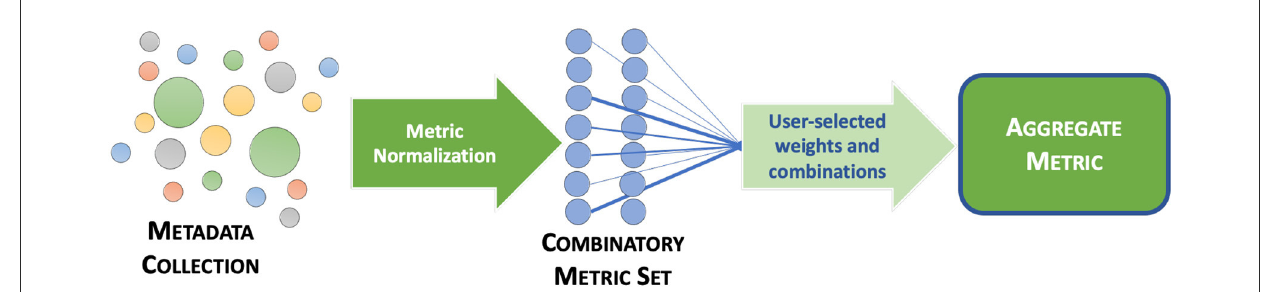
FIGURE2 Conceptual framework of the risk-triage approach. The supporting web platform consists of a metadata collection obtained from various repositories and sources whose data differ in attributes, formats, content, units, granularities, etc. (i.e., Appendix A). From this ecosystem of data, a subset of the data is chosen that span across the multi-sector dynamics (MSD) purview (e.g., Reed et al., 2022). These data are further refined and normalized into a set of metrics that can be used for combinatory analyses. The platform is designed to be flexible and interactive—such that the user can select their own combination and weights (conceptually depicted by the line thicknesses) of these metrics. The result is an aggregate metric where the user can download the resulting set of data and map image created by the platform (URL: